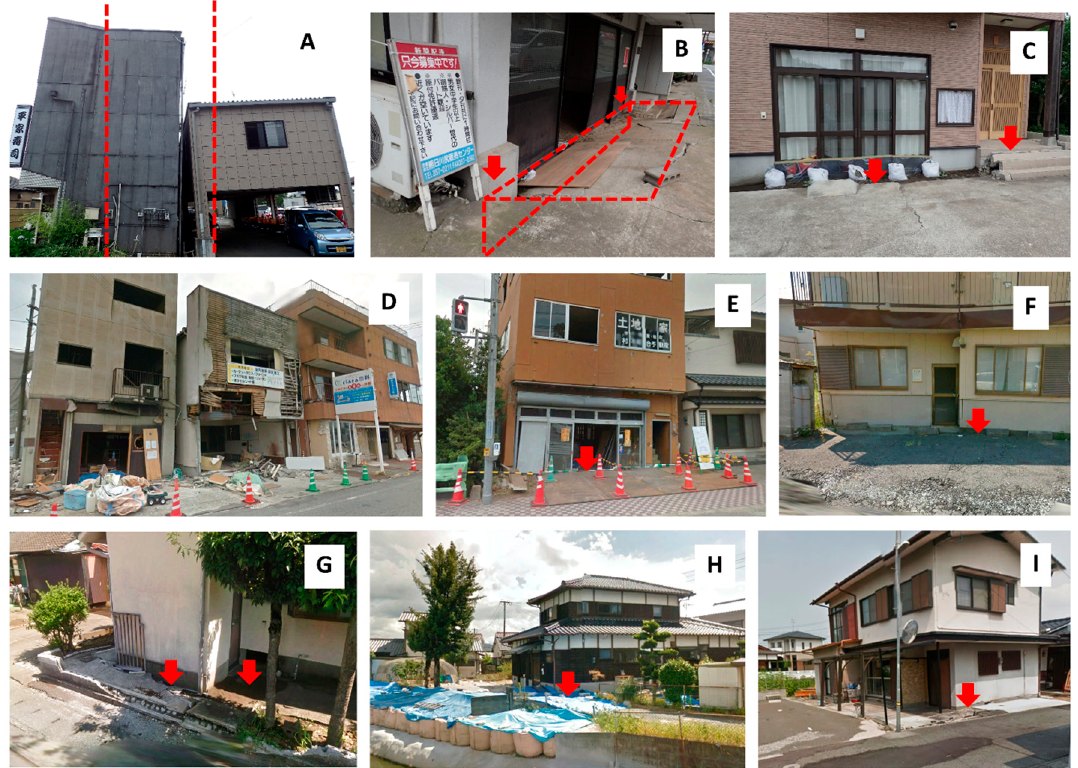
Figure 9. ( A – I ) Example locations for damaged buildings in the liquefaction area. The damage patterns are subsidence, inclination and other structural building damage. ( A ) building damaged by high inclination and subsidence, ( B ) building with high subsidence level, ( D ) other structural building damage, ( G ) sand boils around buildings and, ( C ), ( E ), ( F ), ( H ) and ( I ) slight subsidence and inclination buildings